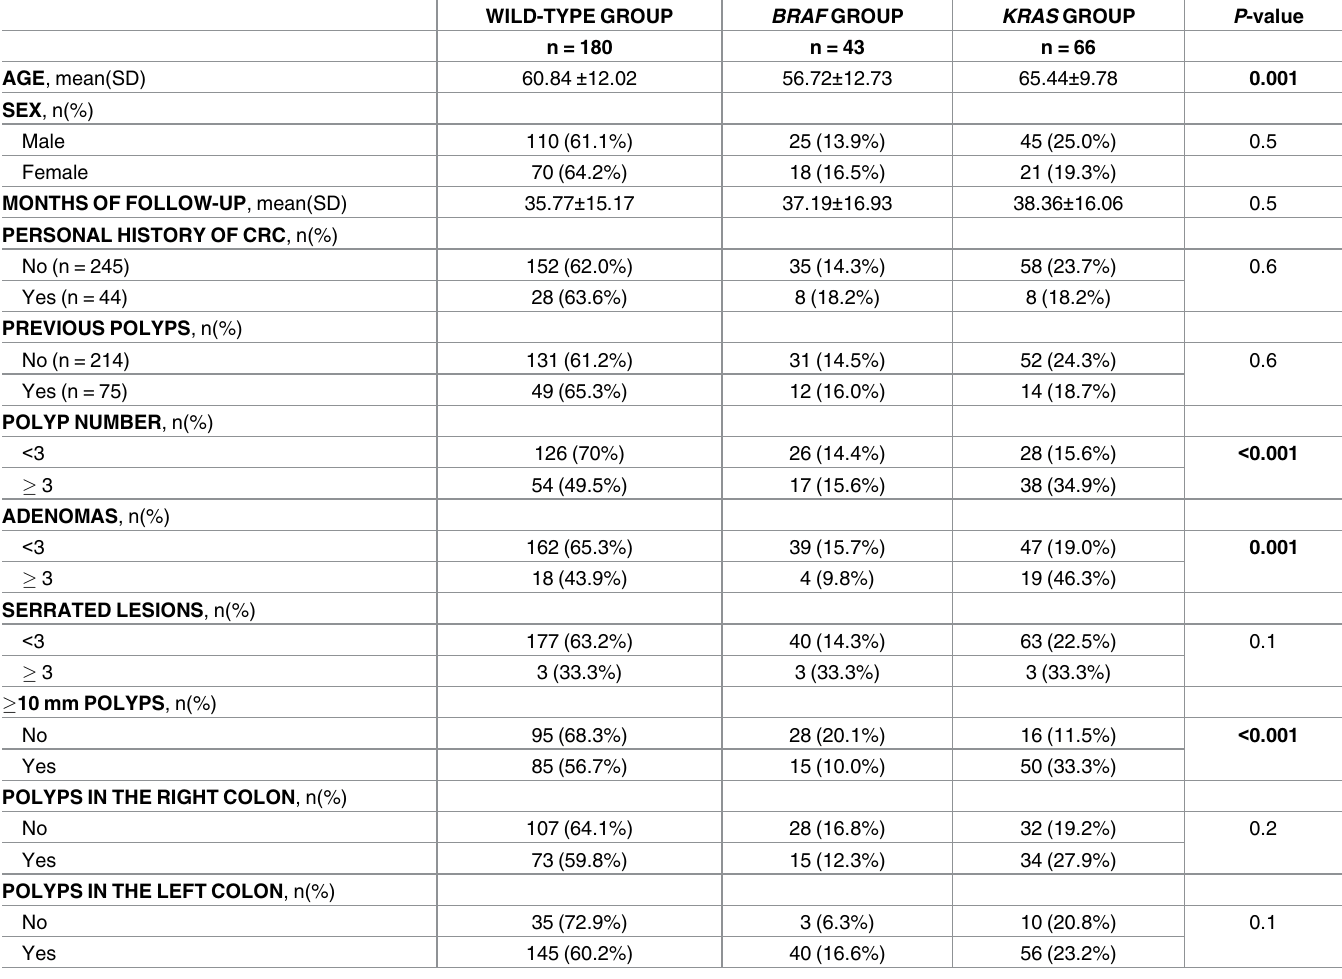
Table 2. Clinical characteristics of patients, according the polyp mutational profile assessedat a baseline